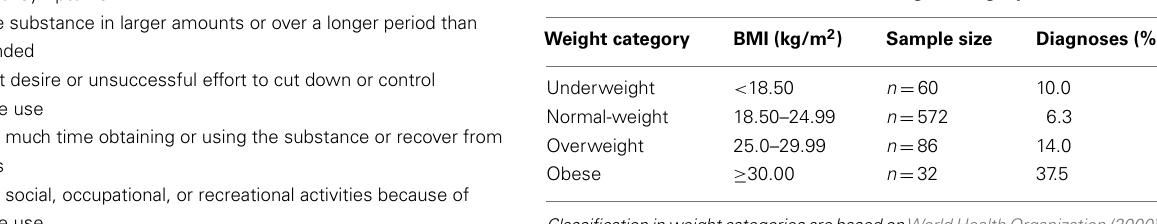
Table 2 | Percentage of food addiction diagnosis according to theYale FoodAddiction Scale as a function of weight